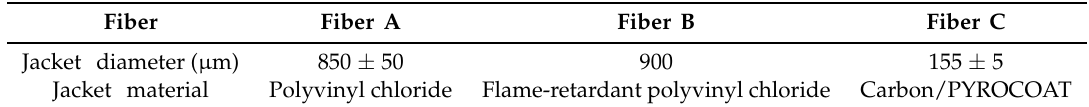
Table 1. Diameters of the jacketed